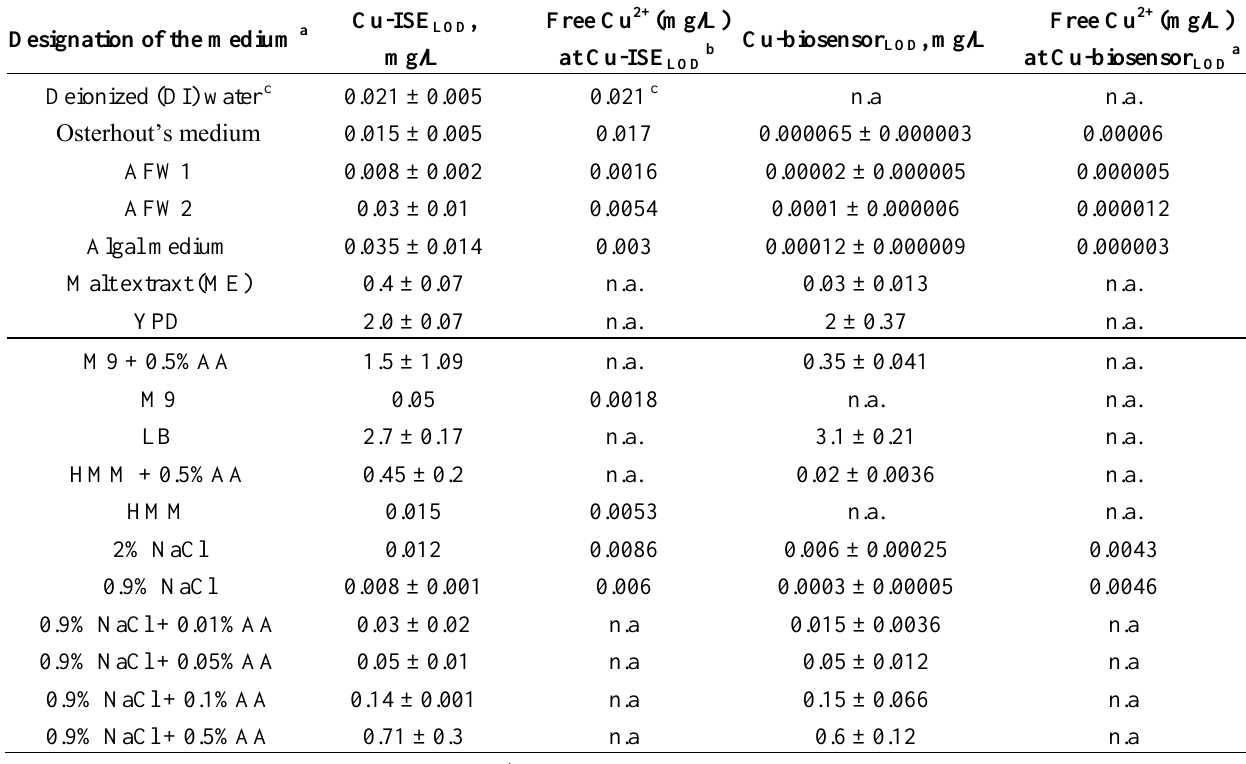
Table 2. Limit of detection (LOD) of the Cu-ion selective electrode (Cu-ISE) (indicative of free Cu ions) and Pseudomonas fluorescens OS8::KnCueRPcopAlux Cu-biosensor (indicative of bioavailable Cu) for CuSO in selected ecotoxicological and microbiological media. 4 Average of three replicates ± standard deviation is shown. Data calculated from Figure